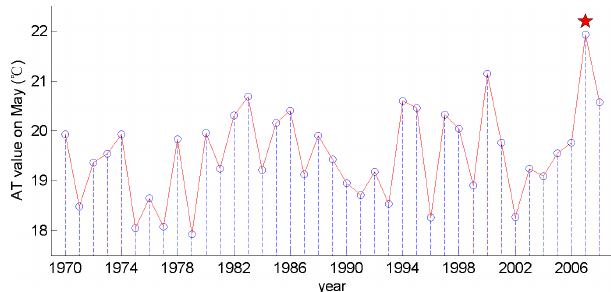
Fig. 6. Air temperature variation in May, from 1970 to 2009, at the point 30 ◦ N, 105 ◦ E (red star points to the year in which earthquake happened).